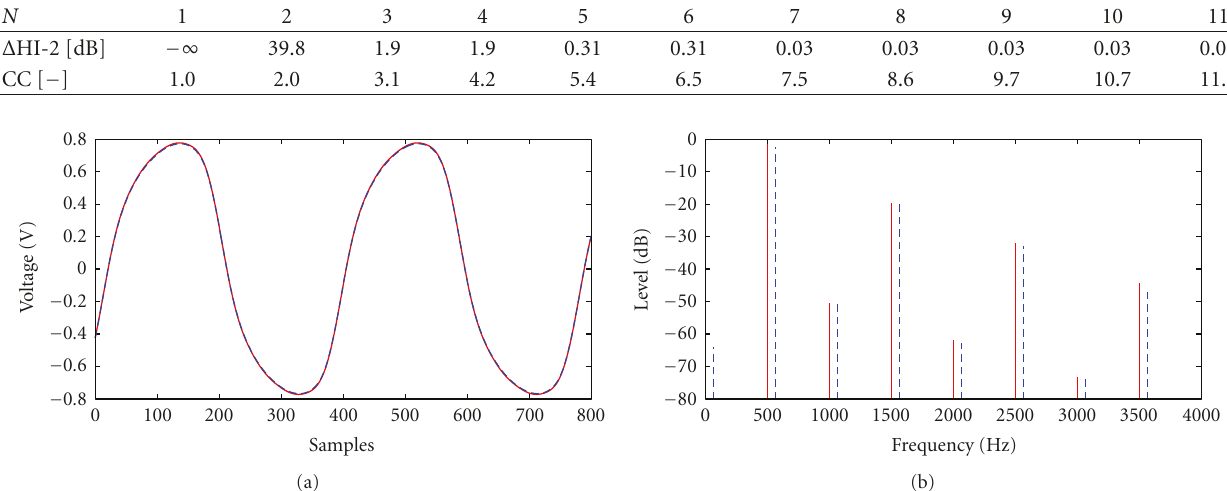
Table 1: E ff ect of the number of branches N of the GPH model on the weighted harmonic distortion di ff erence Δ HI-2 and on the relative computing complexity CC.